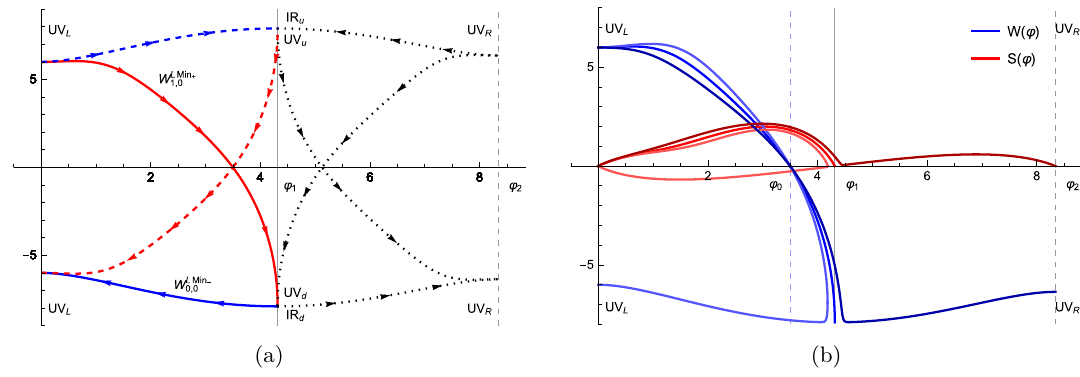
Figure 36 . (a): an example of a flow between a maximum and a minimum. For the solid curves, ( Max ) is a flow between a UV fixed point at maximum ϕ = 0 and another UV fixed point − , Min + at the minimum ϕ = ϕ . For the ( Max ) part of the solution, the minimum is an IR fixed 1 − , Min − point. The dashed curves show the flipped image of the solid curves. The black dotted curves are other possible flows with the same UV fixed points. (b): at a fixed ϕ when the value of S is exactly 0 0 on the border of type W LR and type W LL , we have the W L Min + branch solution (the middle 1 , 0 1 , 1 1 , 0